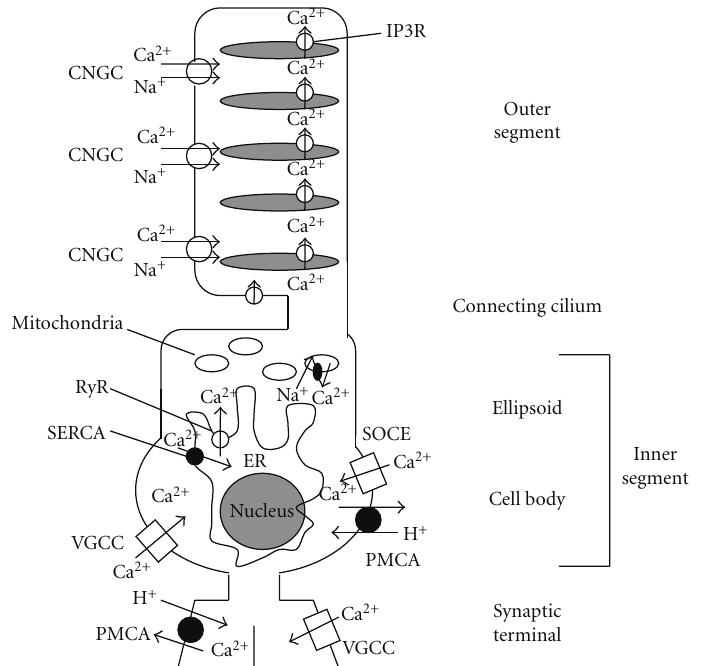
Figure 1: Schematic view of calcium channels and transporters in the rod-photoreceptor. Abbreviations: CNGC, cyclic-nucleotide-gated cation channel; VGCC: voltage-gated calcium channel; PMCA: plasma membrane calcium ATPase; SOCE: store-operated calcium entry; ER: endoplasmic reticulum; SERCA: sarcoplasmic-endoplasmic reticulum Ca 2+ -ATPase; IP3R: inositol 1, 4, 5-triphoaphate receptor; RyR: ryanodine receptor. Ca 2+ stock and release from the mitochondria are mediated by Ca 2+ uniporter channels and Na + /Ca 2+ transporters.